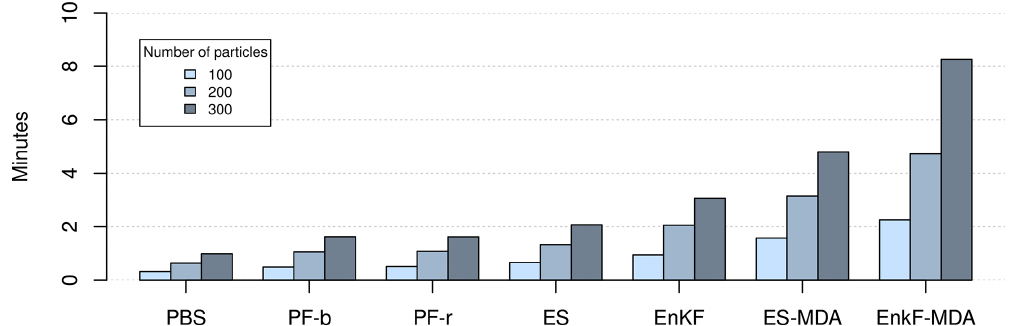
Figure 8. Benchmarks for the computational cost, expressed in terms of wall clock time, of the different assimilation schemes implemented in